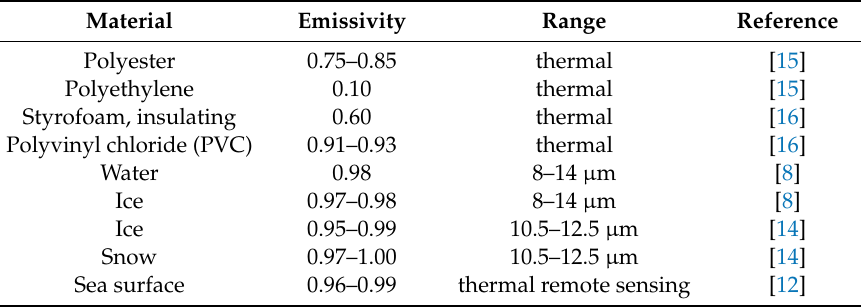
Table 1. Emissivity values of di ff erent polymers and